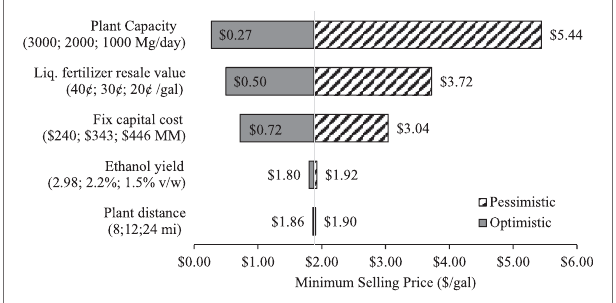
FIGURE 6 | Sensitivity analysis of FW fermentation process integrated with CHP (Optimistic is the best case scenario simulation, pessimistic is the worst case scenario